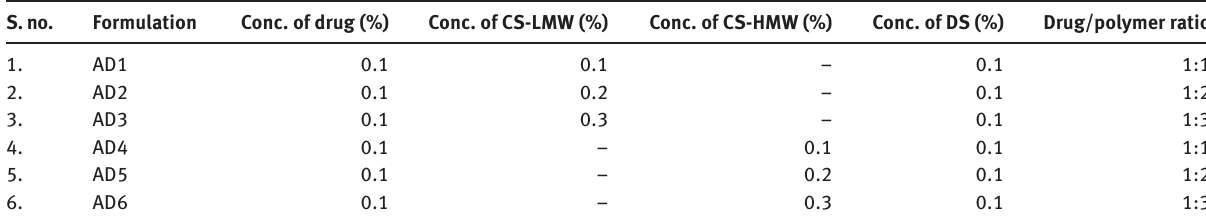
Table 1: Composition of different